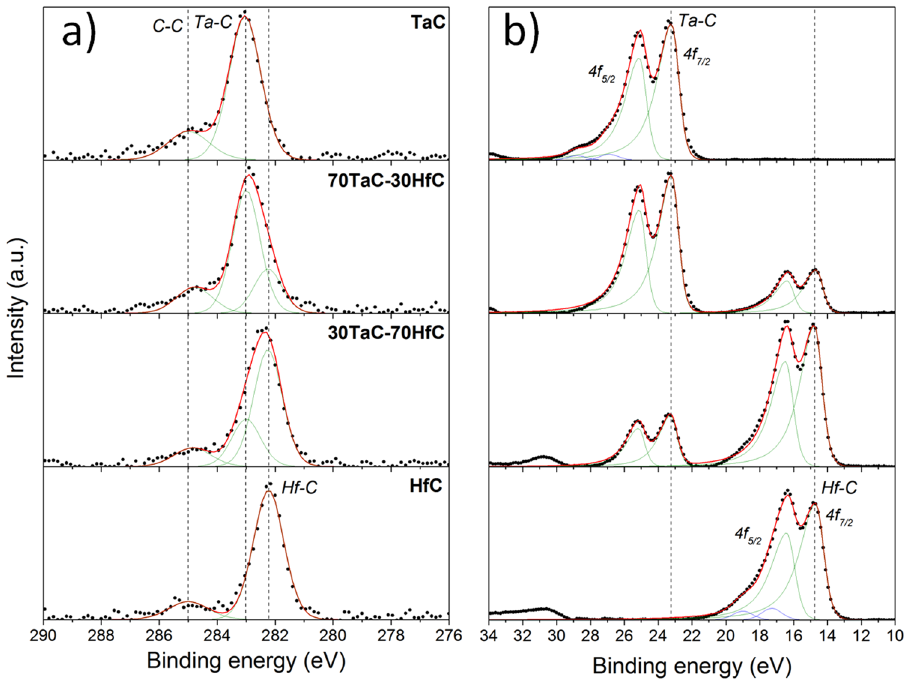
Figure 3. High resolution ( a ) C 1s and ( b ) Ta and Hf 4 f spectra for the different Ta-Hf-C alloy films showing the evolution of the samples as they change from pure TaC to